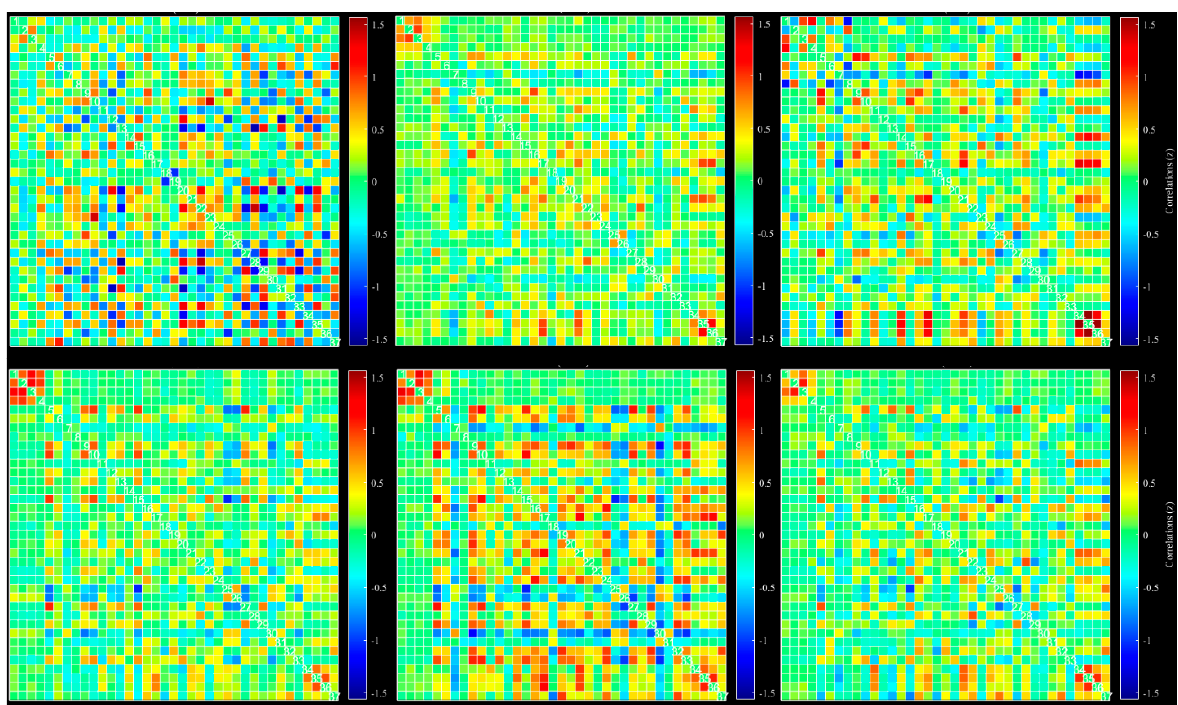
Figure 4. Dynamic functional connectivity of all 37 extracted ICs: six different state, selected based on k-mean clustering.